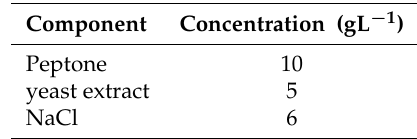
Table 7. Composition of the Lysogeny broth (LB) medium.